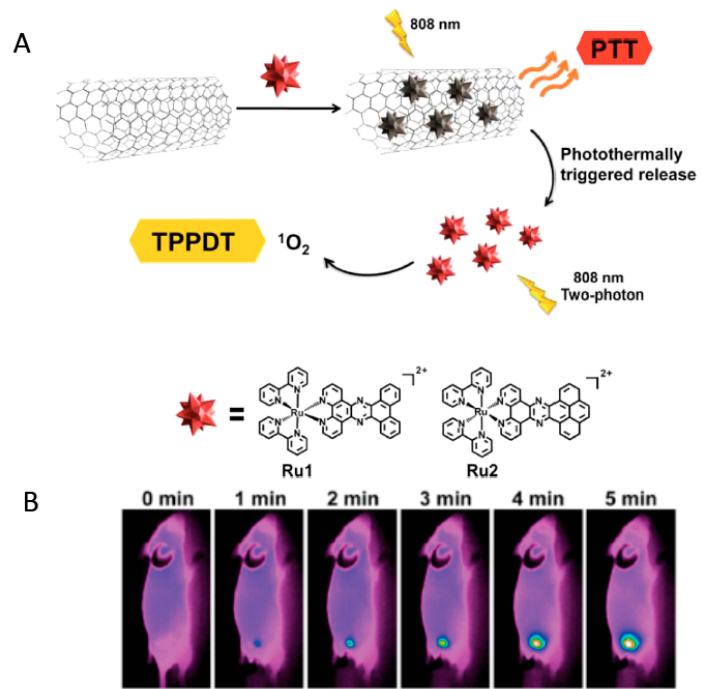
Figure 4. ( A ) Schematic design of Ru@SWCNTs. ( B ) Thermographs of tumor-bearing mice receiving photothermal treatment with Ru1 @SWCNTs different periods of time (0 to 5 min). Reprinted with permission from reference [84].